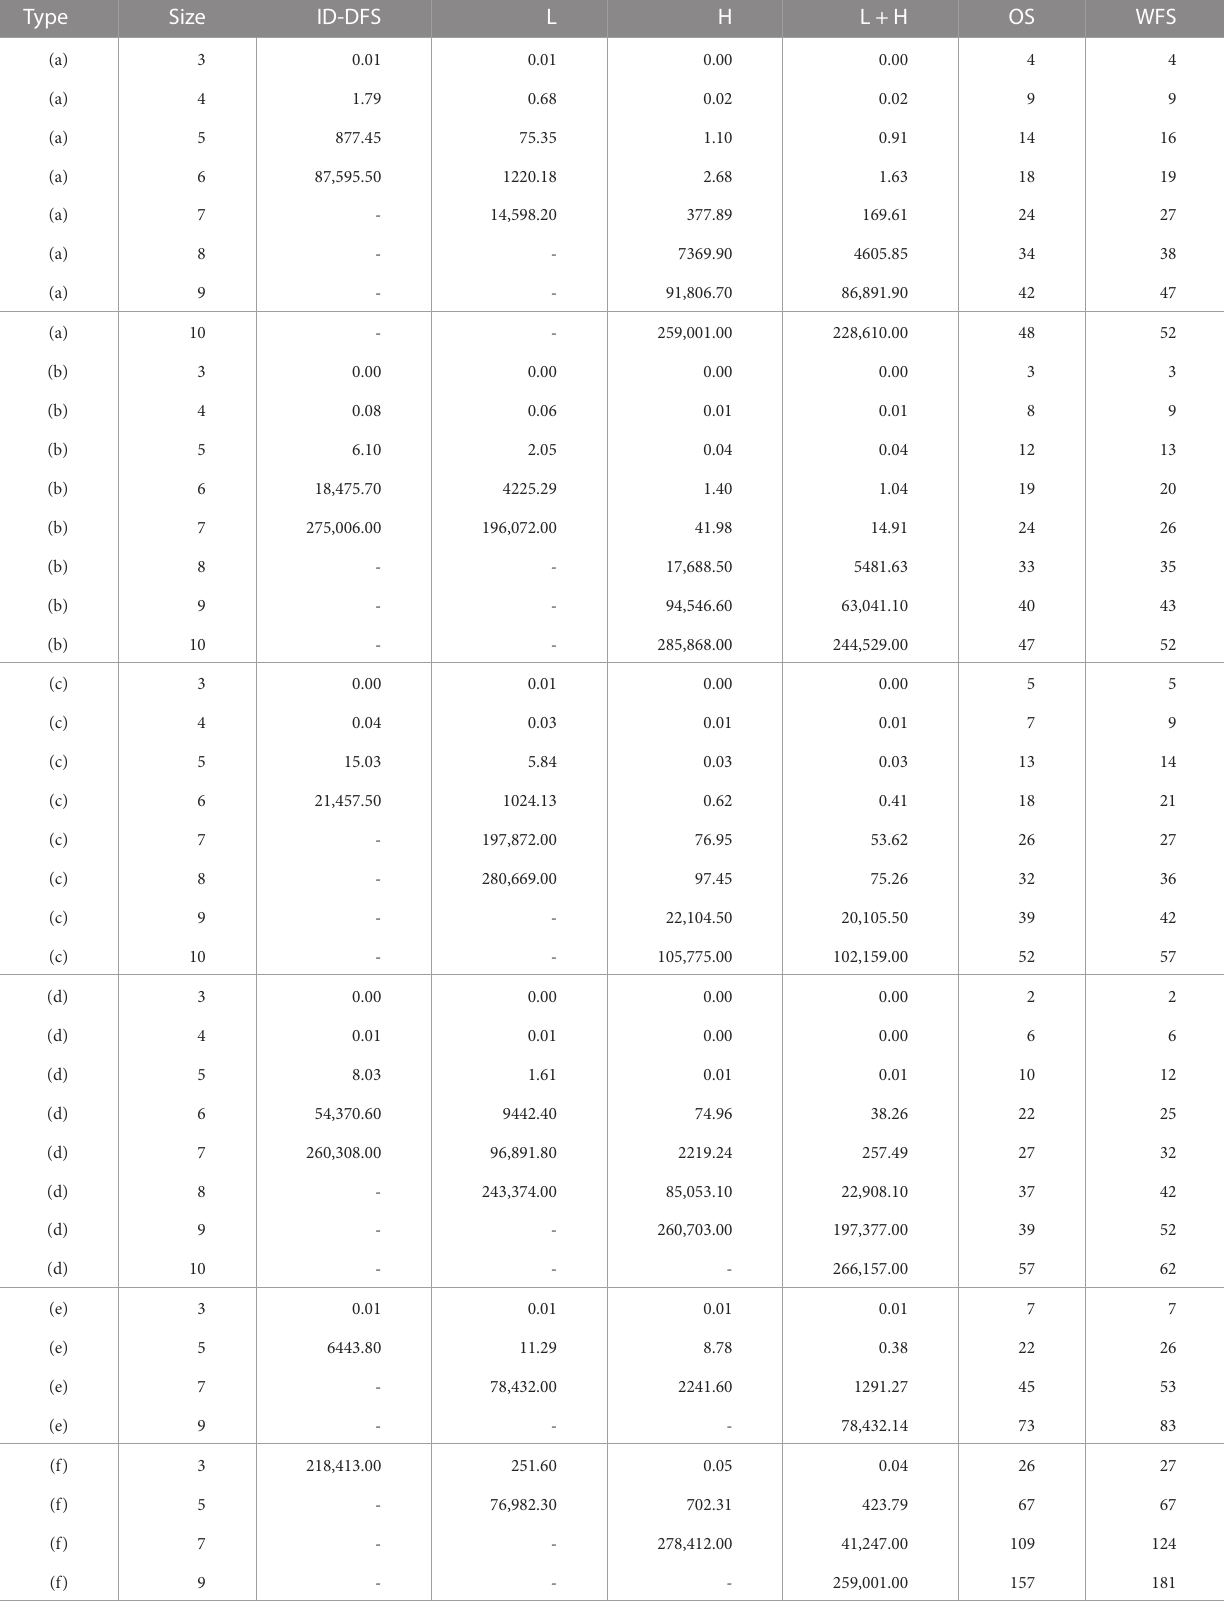
TABLE1 Averagerunningtimes(inms)obtainedbytheproposedplanners.Columns“OS”and“WFS”givethelengthofanoptimalsolutionandofthesolution obtainedwiththeapproximatewavefrontsolver.Thesymbol‘-’indicateswhenasolvercouldnotsolveaninstancewithin5 min.